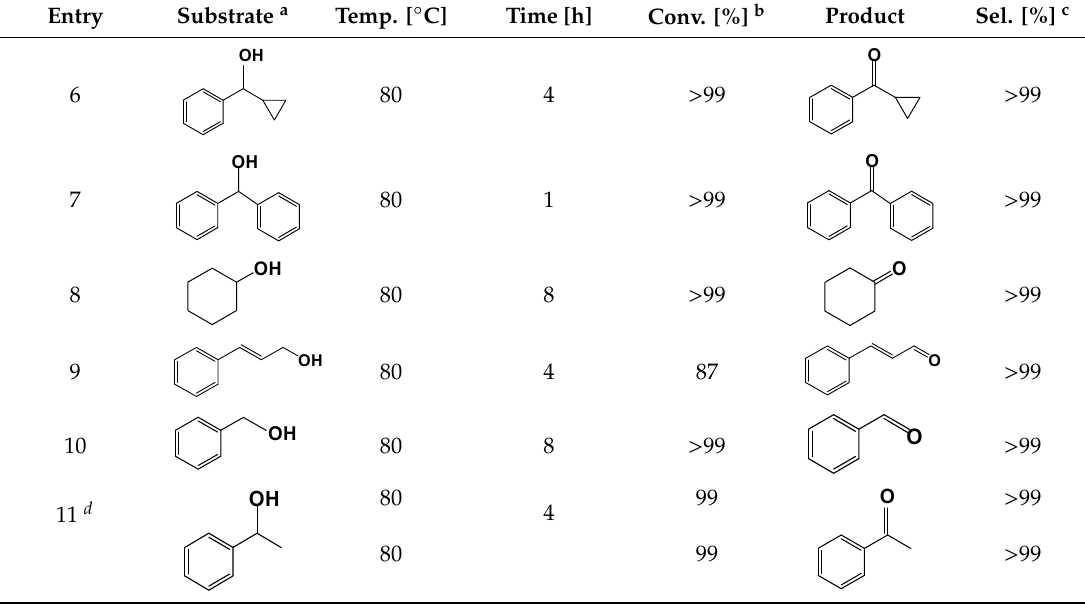
The conversion were determined by GC-MS using dodecane as the internal standard. c The selectivity of products calculated by conversion and GC-MS analysis. d recyclin g reaction results of the 2nd and 3rd